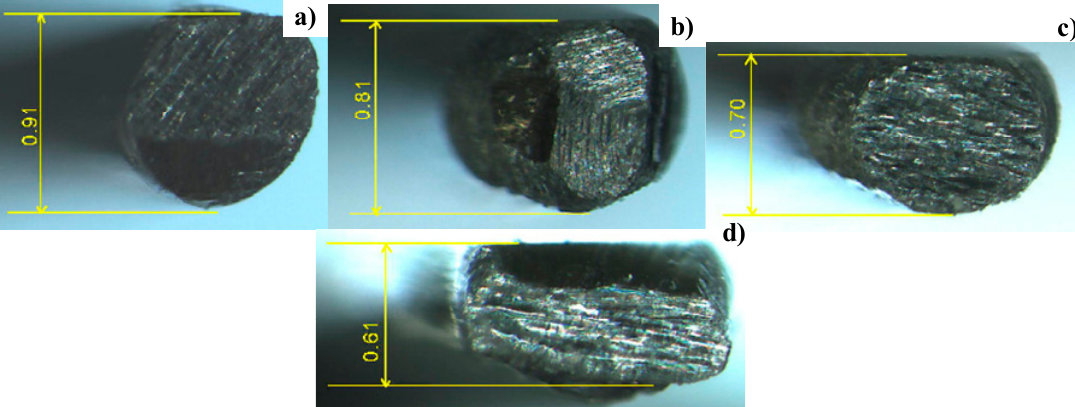
Figure 6. Variation of the cross-section of forged AISI316 wires by forging with increasing the reduction of the diameter. ( a ) r = 10%, ( b ) r = 20%, ( c ) r = 30% and ( d ) r = 40%.